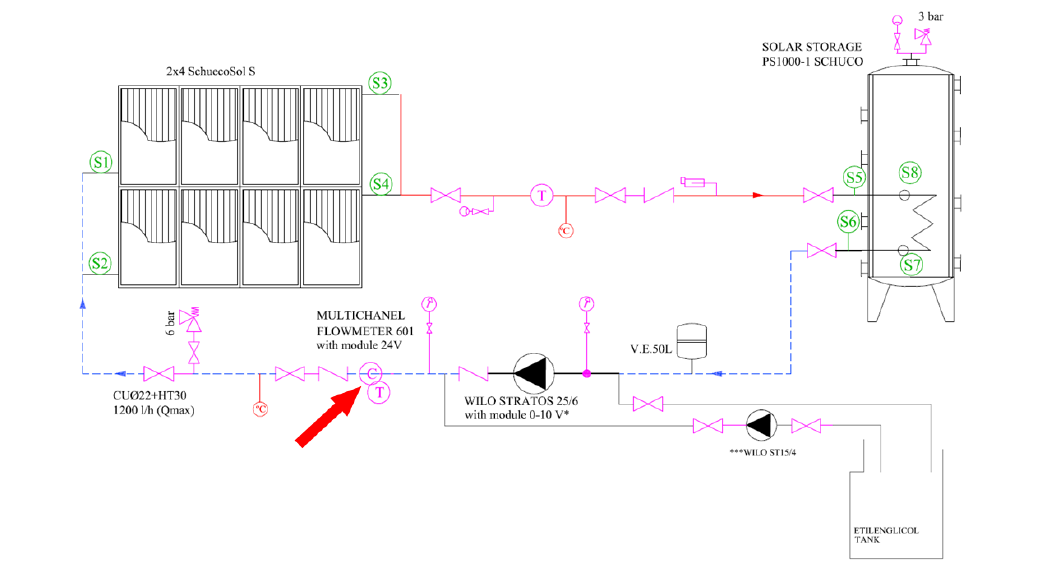
Figure 3. Solar thermal energy